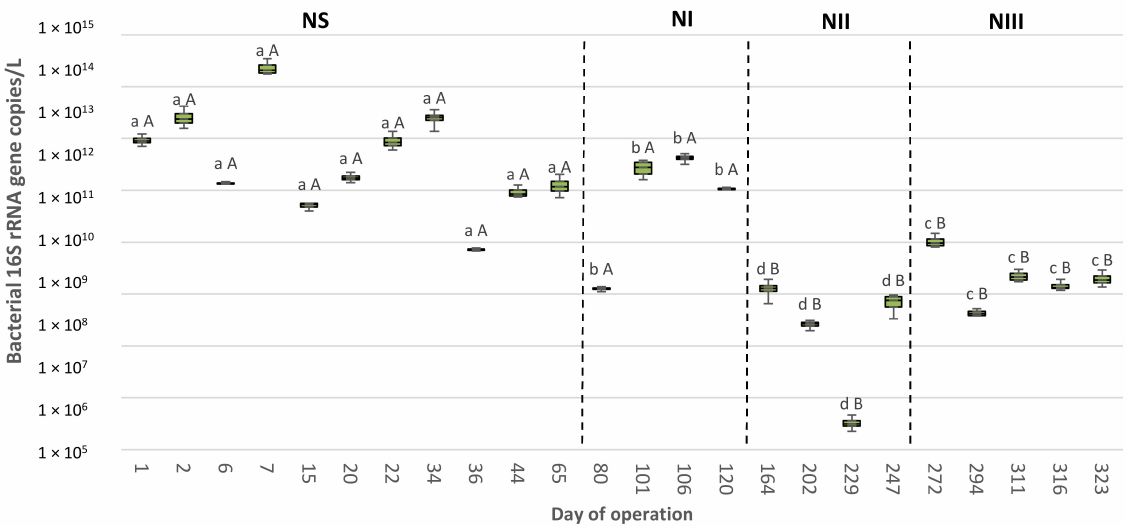
Figure 1. Bacterial 16S rRNA genes copies per liter of enriched activated sludge determined by quantitative PCR in sludge samples ( n = 2) retrieved from an enrichment SBR operated under non- saline conditions (SBR-N, 0.5 g NaCl/L). Different lowercase letters indicate significant differences among periods for a given bioreactor (NS, NI, NII, or NIII; SS, SI, SII, or SIII) according to the Kruskal– Wallis and Conover–Iman tests ( p < 0.05). Different capital letters indicate significant pairwise differences between bioreactors for a given period (NS vs. SS; NI vs. SI; NII vs. SII; or NIII vs. SIII) according to the Mann–Whitney test ( p < 0.05).